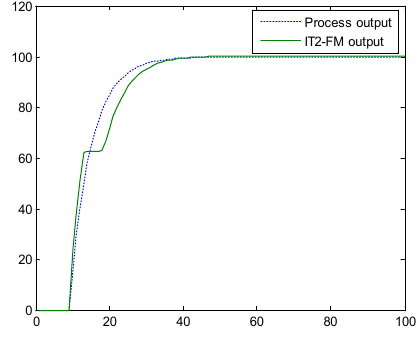
Figure 6. IT2-FM output approach process output.